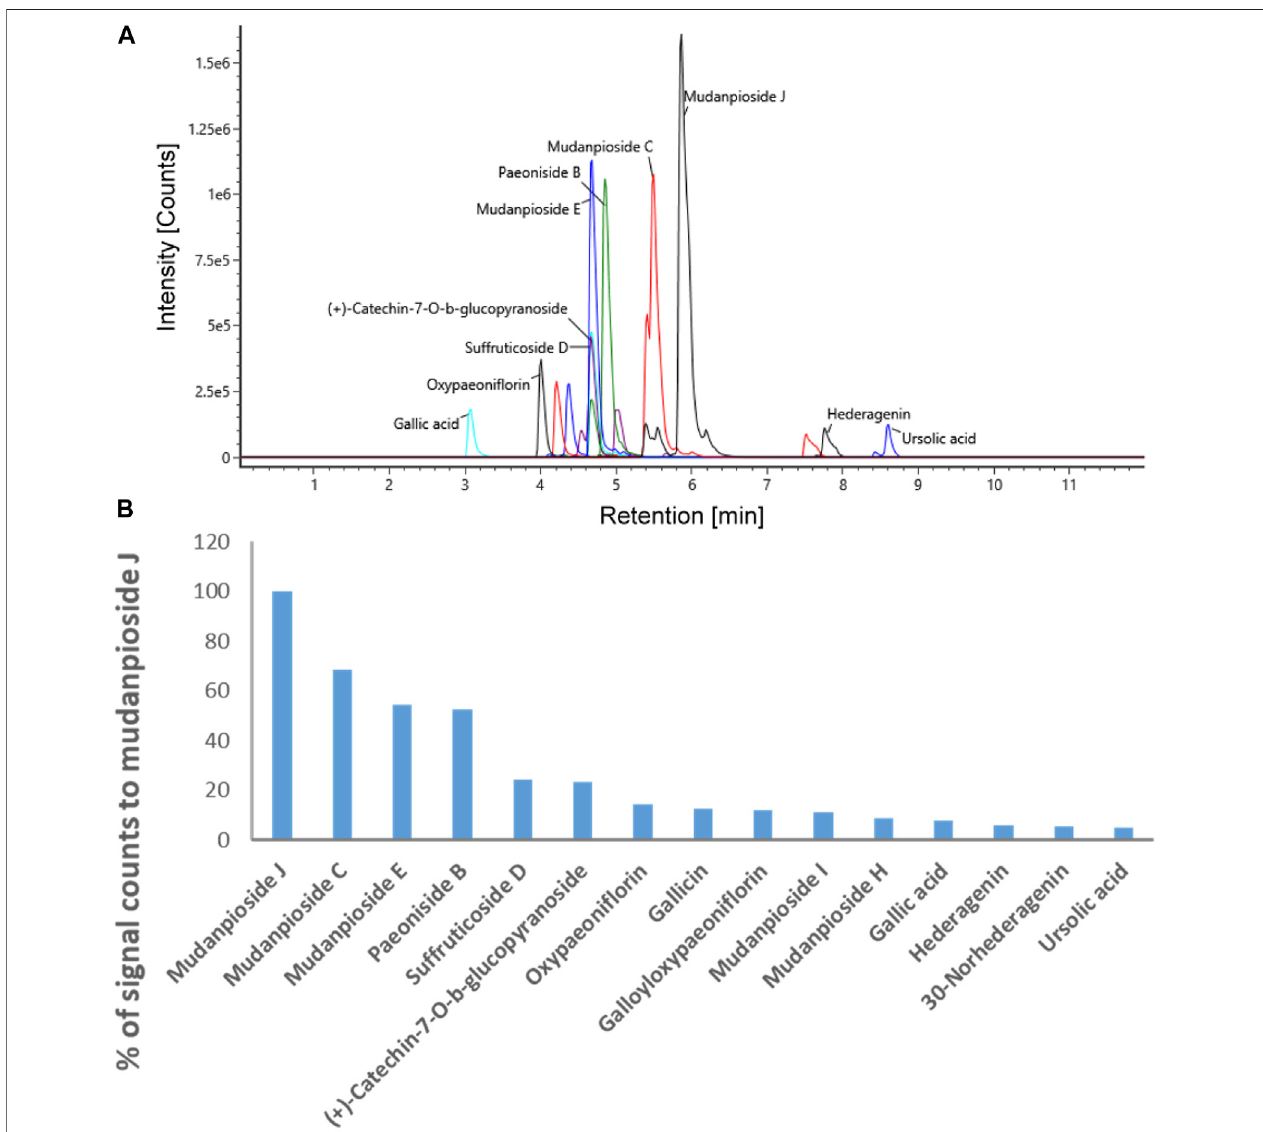
FIGURE 7 | The MDP5 chemopro fi le. (A) The extracted ion chromatograms (theoretical m/z ± 16.8 ppm) with signal responses among the top 15 of all identi fi ed compound candidates. (B) The relative levels of signal responses amongst the compound candidates.